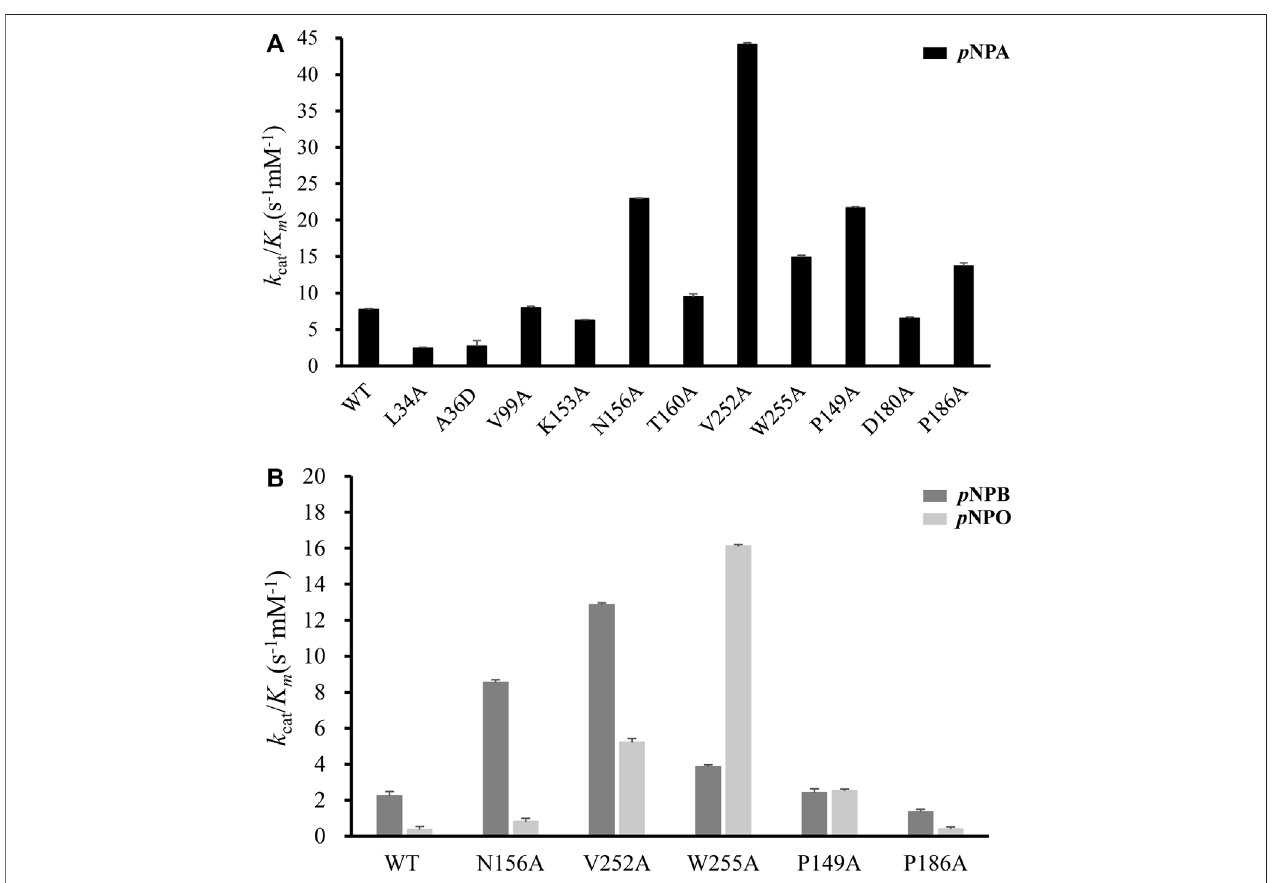
FIGURE 6 | Comparison of the catalytic ef fi ciency (represented by k cat / K m ) measured for wild-type Df FAE and its mutants. (A) The k cat / K m values on p NPA for WT and all mutants (B) The k cat / K m valuesofWT and somemutants on p NPBand p NPO.The errorbars indicatedthe standard errorsfrom three independent experiments.